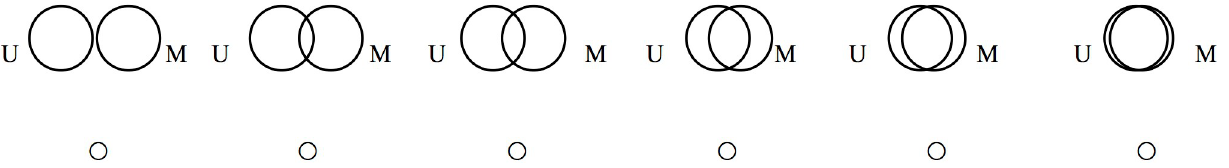
Fig 1. Adapted inclusion of community in self (ICS) scale. Source : Author’s own illustration based on Mashek et al. [88].